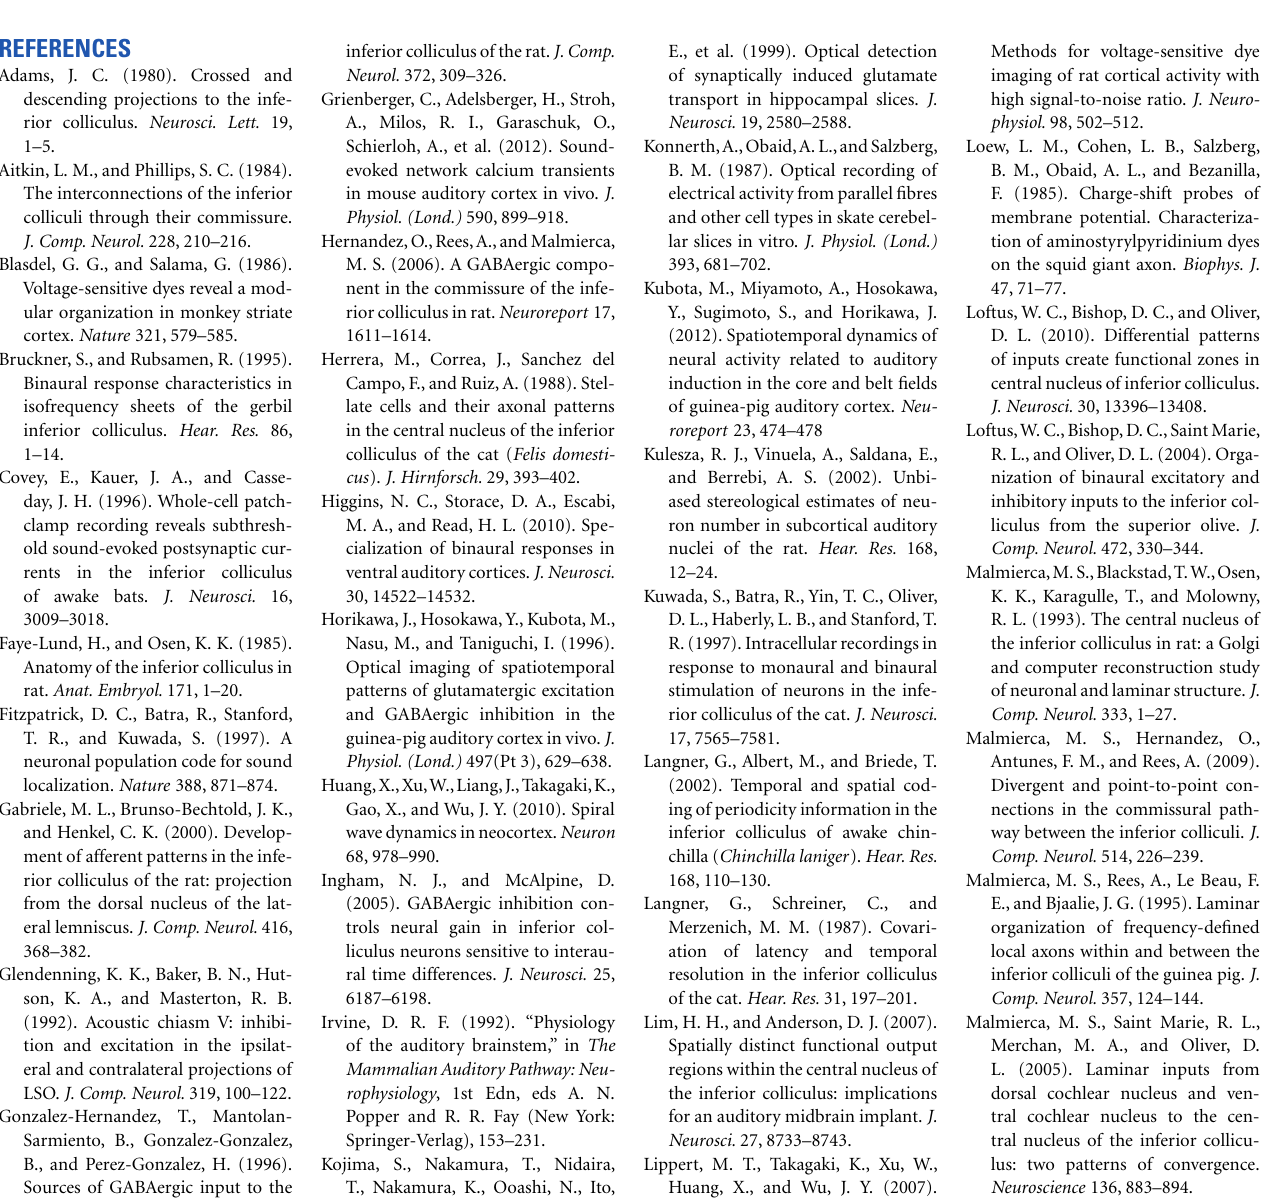
Movie S1 |VSD recording of activity in a transverse slice of the IC in response to a single LL shock. Movie corresponds to Figure 7 . Movie S2 |VSD recording of activity in normalACSF. Movie corresponds to Figure 9A . Movie S3 |VSD recording of activity in SR95531. Movie corresponds to Figure 9B . Movie S4 |VSD recording of activity in a laminar slice in response to a single LL shock. Movie corresponds to Figure 10 . Movie S5 |VSD recording of activity in a transverse IC slice evoked by an LL stimulus train. Movie corresponds to Figure 13C . Movie S6 |VSD recording of activity in a transverse IC slice to a stimulus that evoked a circuit involving post-inhibitory rebound neurons. Movie corresponds to Figure 14B